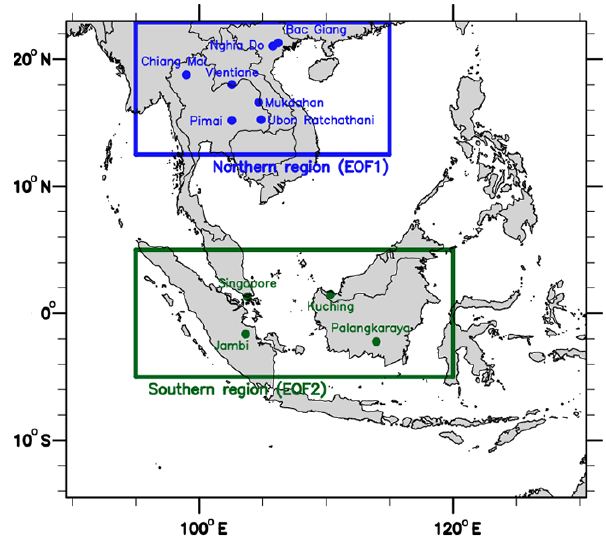
Figure 1. Domain with the two EOF regions highlighted and the location of the AERONET